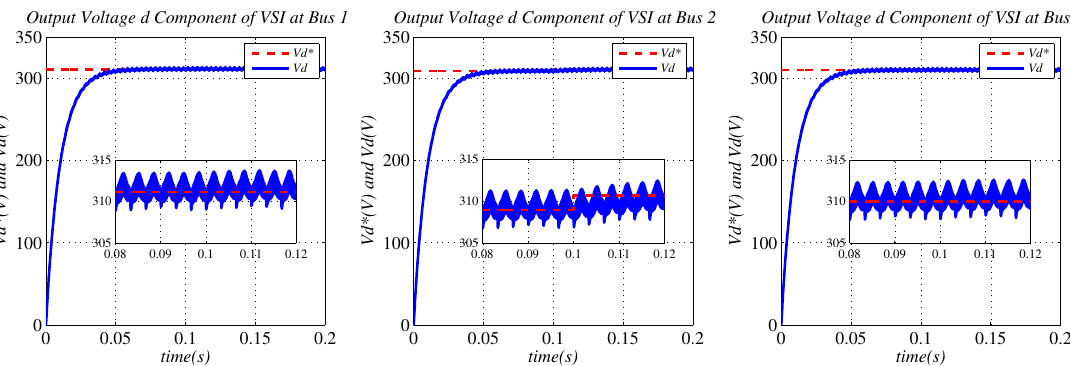
Figure 17. Output voltage d component of the VSI at Buses 1, 2, and 3 with the nonlinear load.